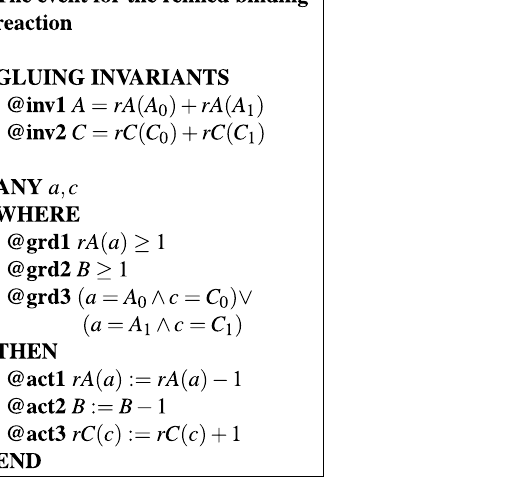
Table 2. Size-preserving refinement of a binding reaction in